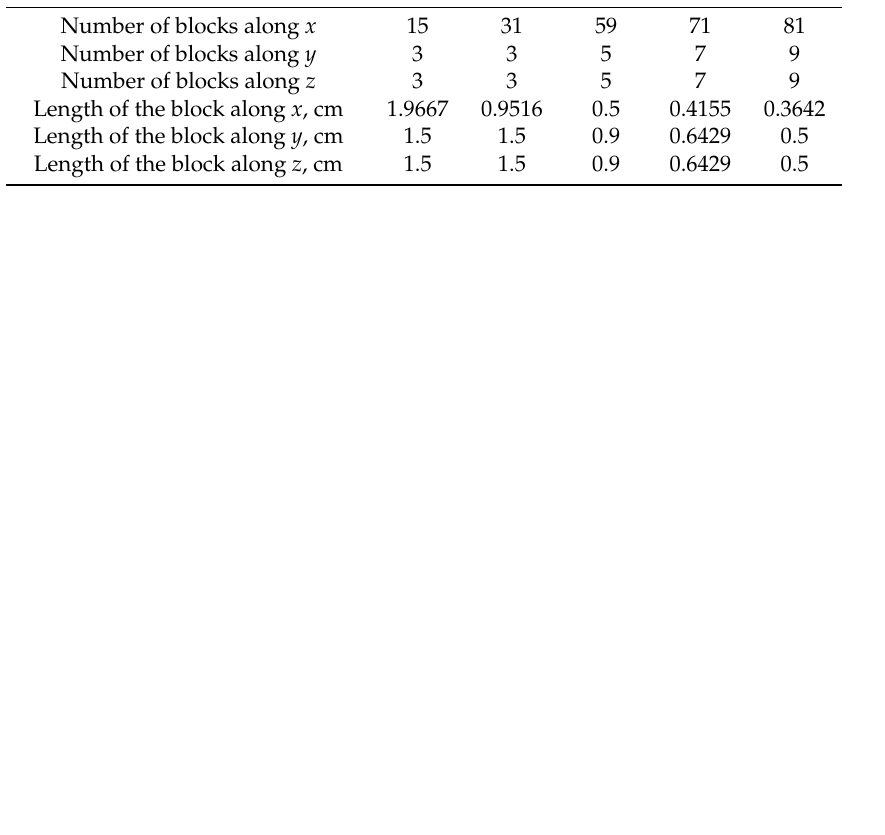
Table 11. The grid information of the simulations used to study the impact of grid size. Parameters